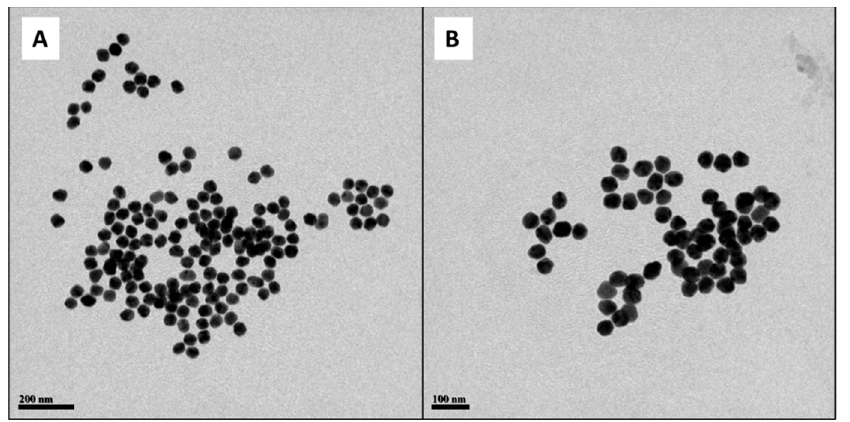
Figure 1. TEM images of Cur-AgNPs. ( A ) 7500 × magnification and ( B ) 10,000 × magnification. The images are the most representative among the five different batches produced with this synthesis.